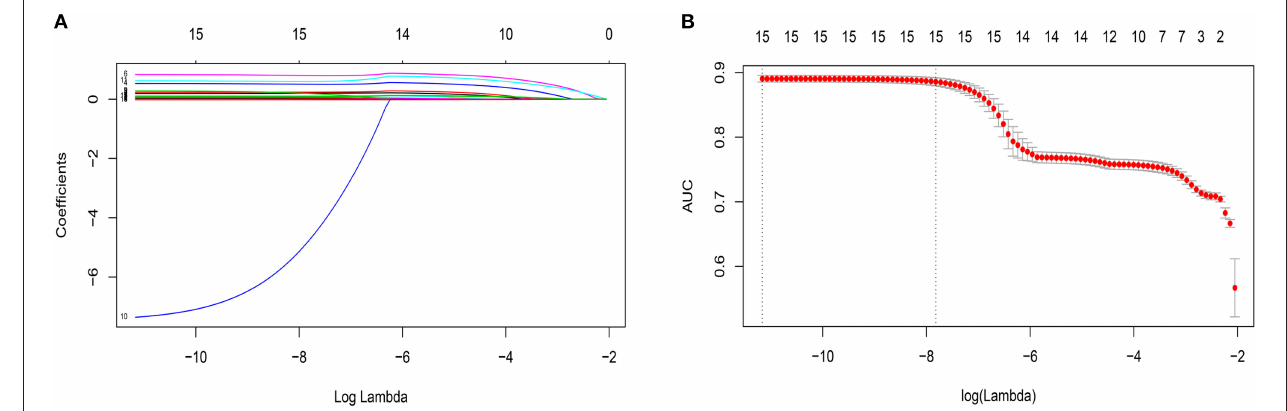
FIGURE 1 | Features selection by least absolute shrinkage and selection operator (LASSO). (A) LASSO coefficients profiles ( y -axis) of the 15 features. The upper x -axis is the average numbers of predictors and the lower x-axis is the log( λ ). (B) Five-fold cross-validation for tuning parameter selection in the LASSO model. The area under the receiver operating characteristic (AUC) with error bar is plotted against log( λ ), where λ is the tuning parameter. The dotted vertical lines are drawn at the optimal values by minimum criteria and the one standard error of the minimum criteria (1se criteria). The upper x -axis is the average numbers of predictors and the lower x -axis is the log( λ ). To avoid overfitting, 1se criteria ( λ = 0.000402) was selected.